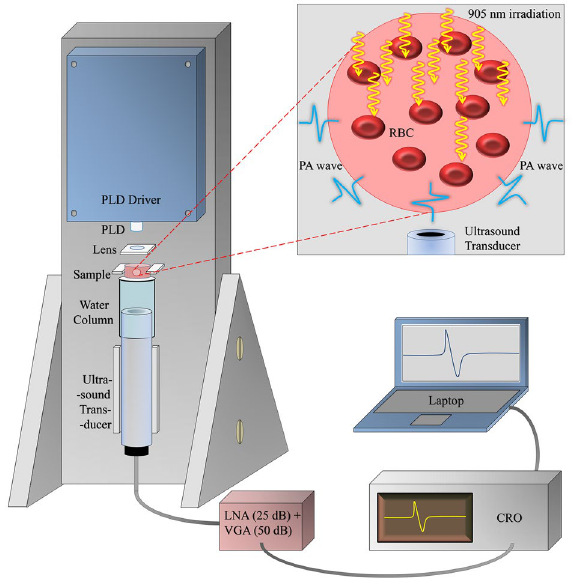
Figure 1. A schematic of the low cost, small footprint photoacoustic system consisting of a 905 nm pulsed LASER diode, a 10 MHz ultrasound transducer placed on a Perspex body in inverted microscope manner.